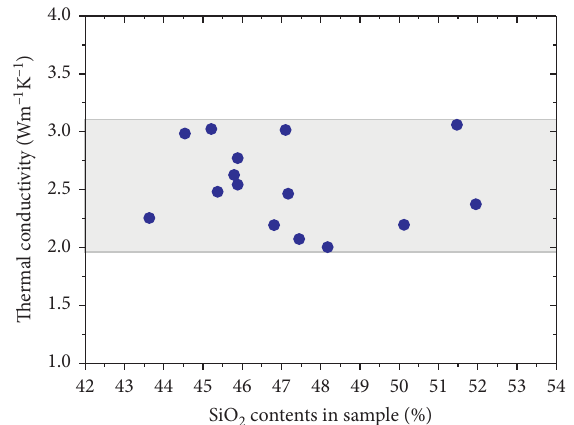
Figure 3: Change in thermal conductivity of basalt samples with the change in silica contents (SiO